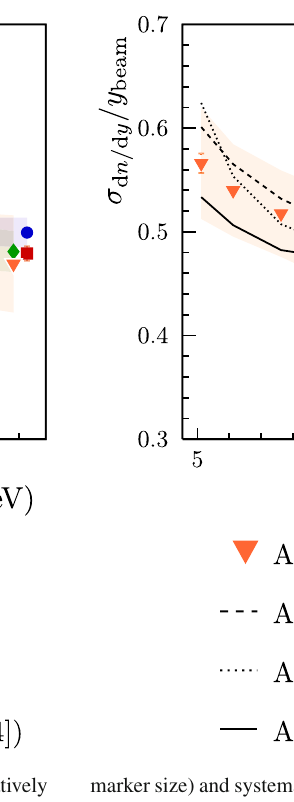
marker size) and systematic (shaded band) uncertainty, whereas Pb+Pb with statistical uncertainty only. Right: Comparison of the results for Ar+Sc collisions as shown in the left plot with Epos , U r qmd and Hijing model calculations (black curves)